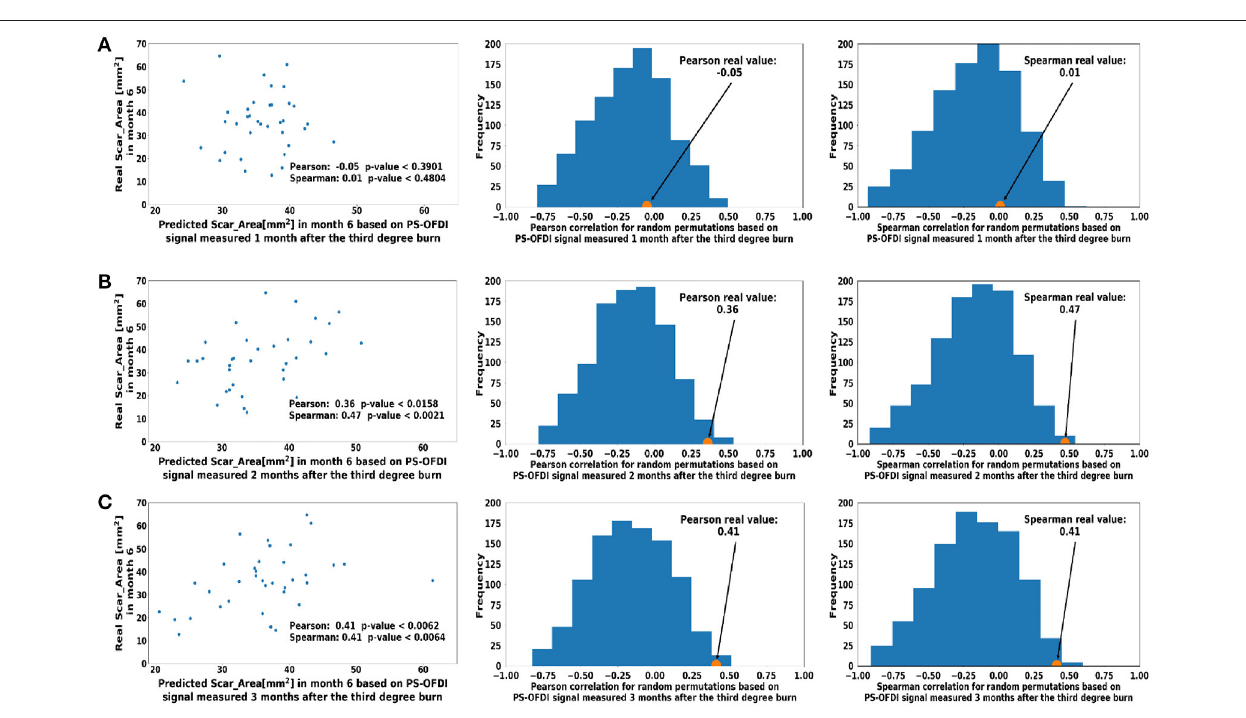
3, respectively. The summary of the model comparison appears in Table 2 . The model coefficients are Figure 4 reported in Tables